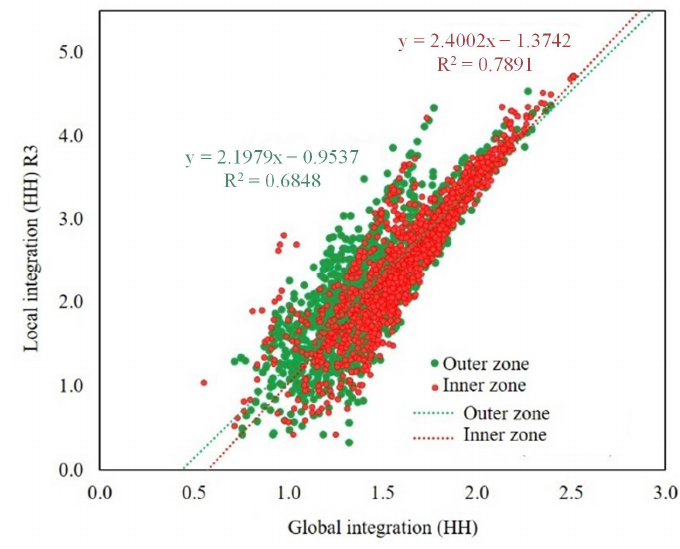
Figure 7. City zone synergy scatter plots comparison .